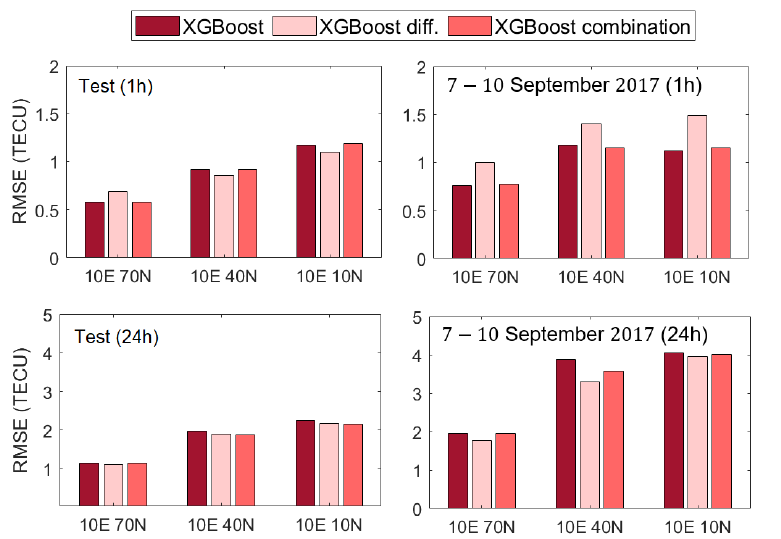
Figure 15. The RMSE for test dataset ( right ) and geomagnetic storm (7–10 September 2017) ( left ) for 1 h ( top ) and 24 h ( bottom ) forecasts for the XGBoost model. Models trained using differenced data are marked with “diff”, while “combination” denotes differenced and non-differenced data together, where exponantial moving averages and time derivatives are calculated from non-differenced VTEC, while the model output is non-differenced